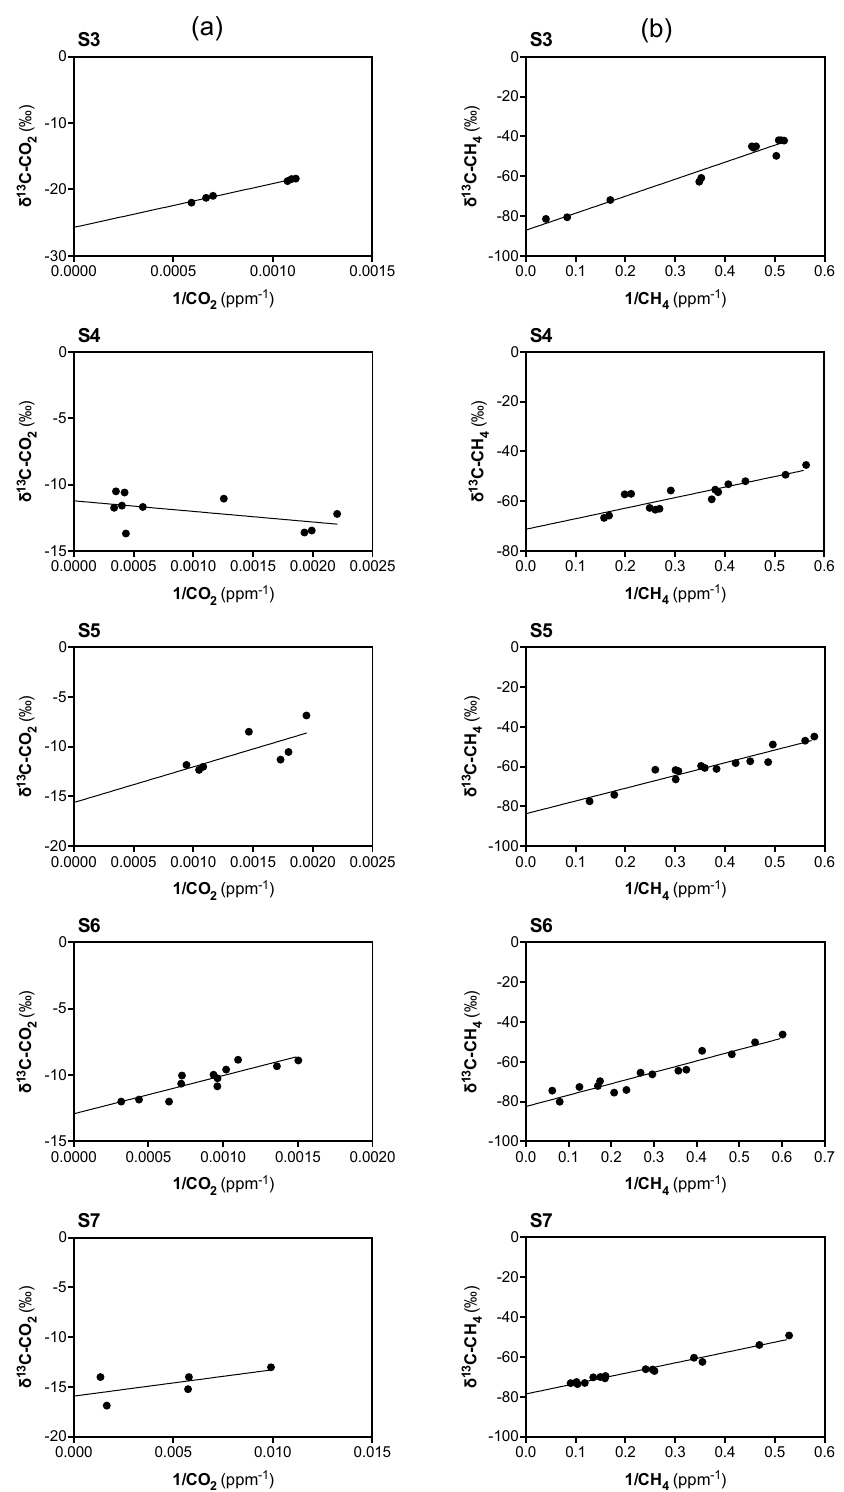
Figure 4. Keeling plots for mangrove stations S3–S7, showing the linear regression of the inverse of CO 2 concentration (a) and CH 4 concentration (b) versus δ 13 C–CO 2 and δ 13 C–CH 4 . Y intercepts were used to estimate the isotopic signatures of produced